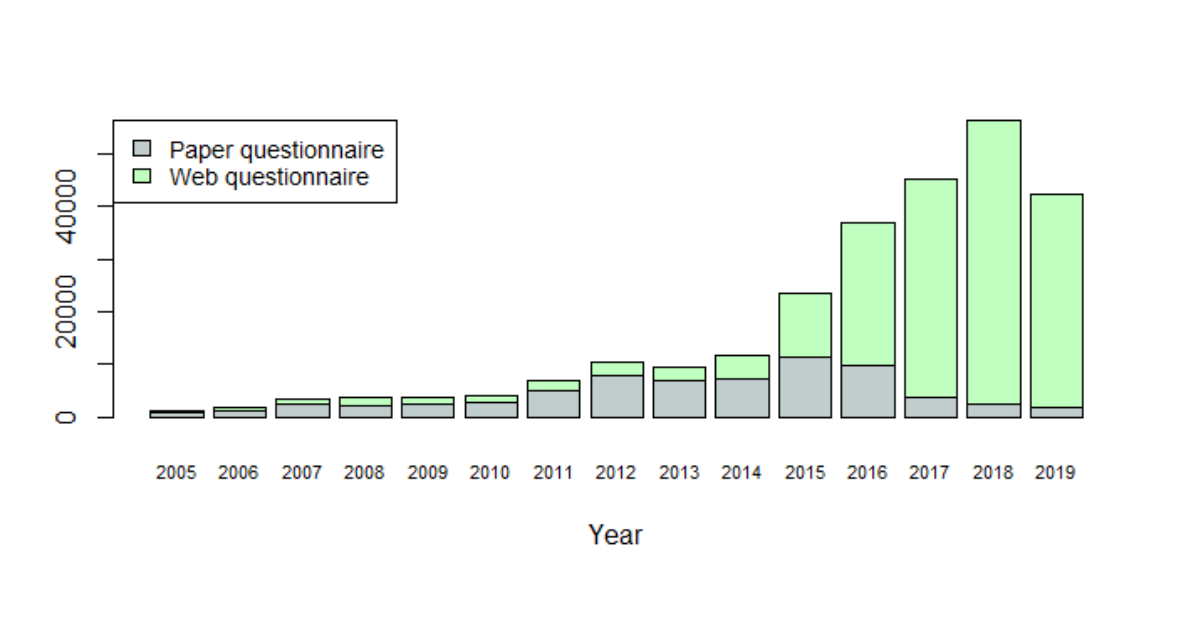
Table 3. Summary of PRO-based projects by year from 2005-2019.